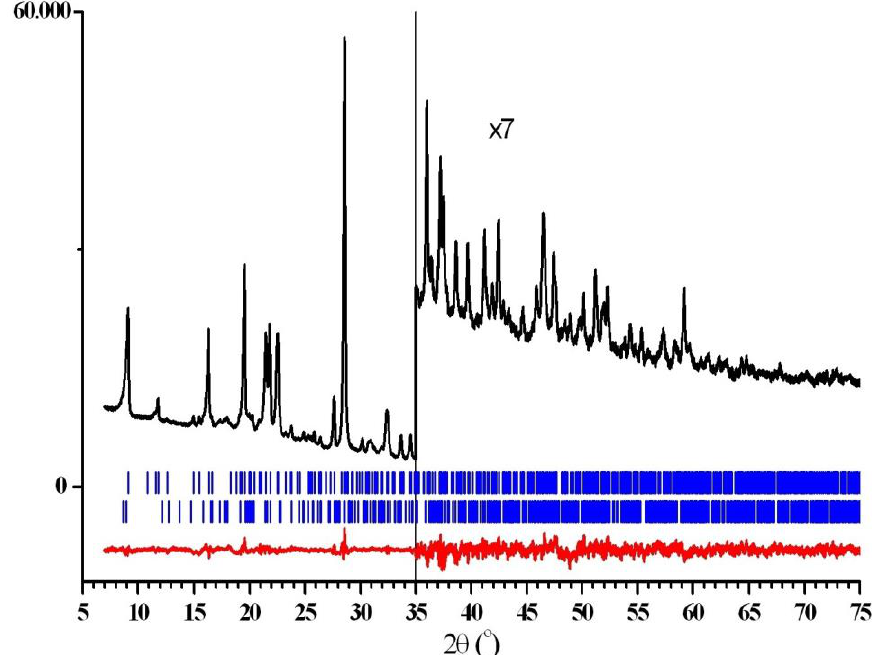
Figure 2. The final Rietveld plot for 4a after the final two-phase refinement showing the experimental diffraction profile in black and the difference (exp – calc) profile in red. The vertical blue bars correspond to the calculated positions of the Bragg peaks for two crystalline phases — 4a (1 st raw) and 4b (2 nd raw).